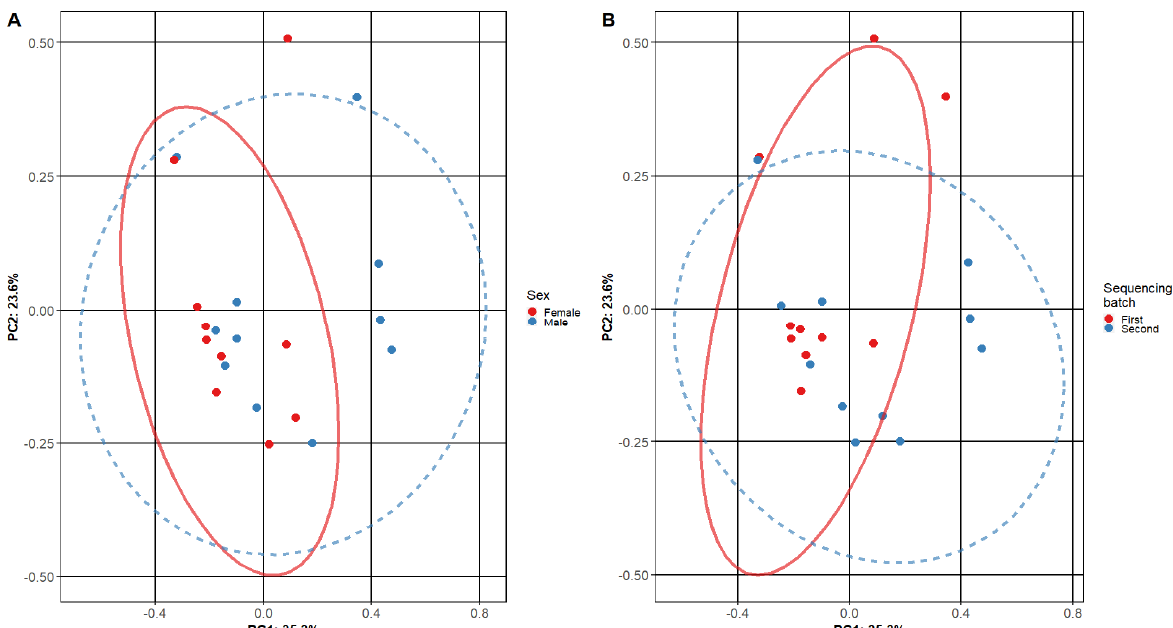
Figure 1. Alpha Diversity of adenoid microbiota. The boxplots are showing the median values and Figure 2. Beta diversity of adenoid microbiome samples. The plots show the composition of interquartile ranges of Fatih’s phylogenetic index (Faith PD), Shannon diversity index and Pielou’s different adenoid microbiome sample subgroups: ( A ) comparing female and male subjects and evenness index.. ( A ) comparing female and male subjects and ( B ) different sequencing batches. ( B ) different sequencing batches. Each point represents the micro-biome signature of one sample, where different colors represent the various sample subgroups. The separation of samples is based on principal components, and the confidence level is set to 95% for ellipses. The overlap of ellipses in both figures indicates similar microbiome composition in the tested